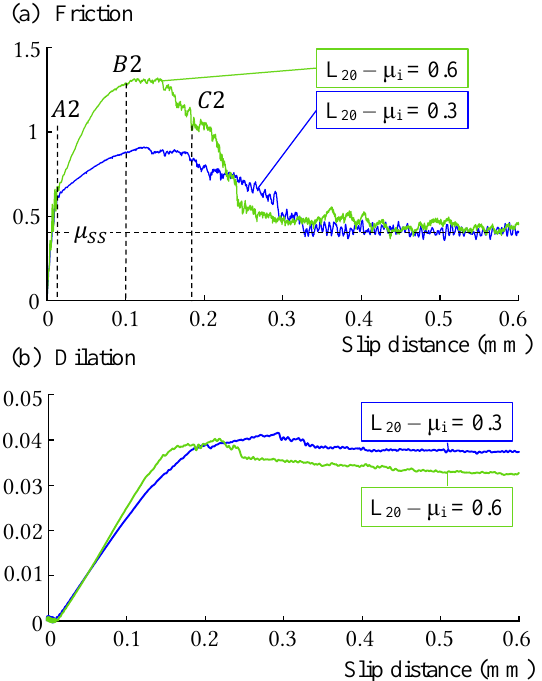
Fig. 5. (a) Friction coefficient as a function of the slip distance (mm) for different inter-particle friction ( 𝜇 𝑖 = 0.3 & 0.6) , for L20 (the same friction peak difference is observed for the other lengths of models). (b) Dilation as a function of the slip distance (mm) for the same cases.